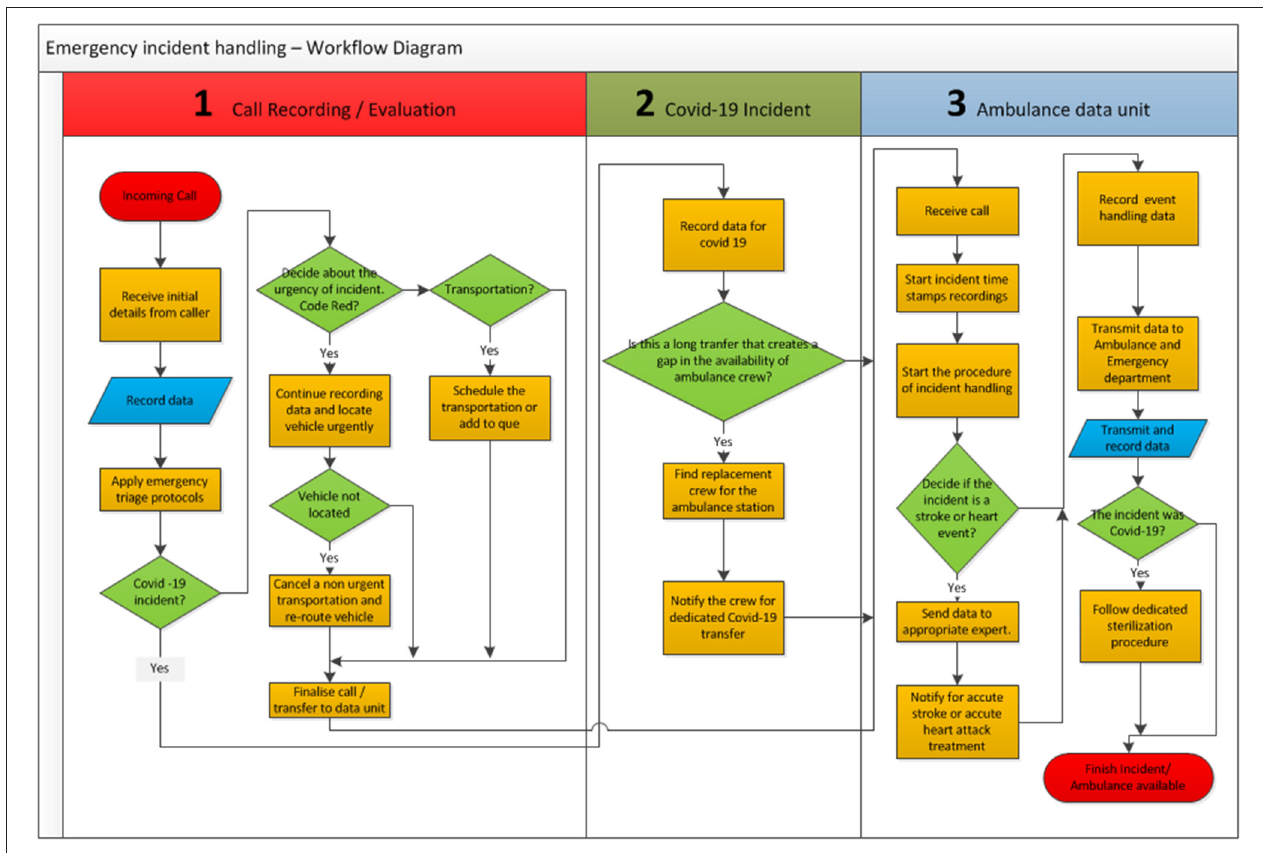
FIGURE 2 | Emergency procedures—workflow management